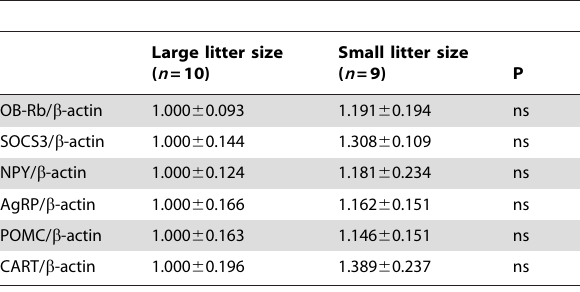
Table 2. Hypothalamic leptin signaling and neuropeptide expression between large and small litters at